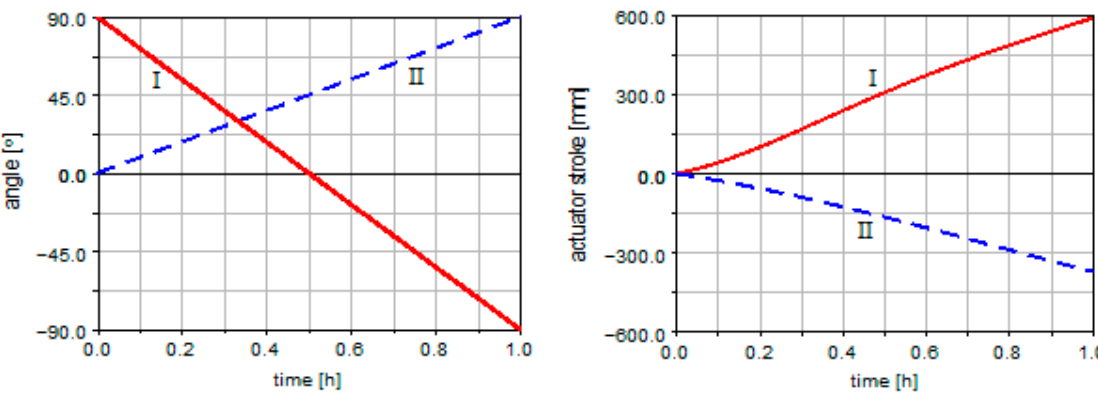
Figure 5. The platform’s positioning angles and the actuators’ linear strokes (I—diurnal motion, II—elevation). The two end (limit) positions of the tracking mechanism/platform, defined by the angle pairs ψ * = 90° (platform facing East), α * = 0° (platform vertically) and ψ * = − 90° (facing West), α * = 90° (horizontally), are represented in Figure 6 (the horizontal axis of this representation is the East–West axis). In the two positions, the linear actuators (i.e., the drivers) are in the following states (L a is the actuator’s length, |AC| or |HJ|, by case):